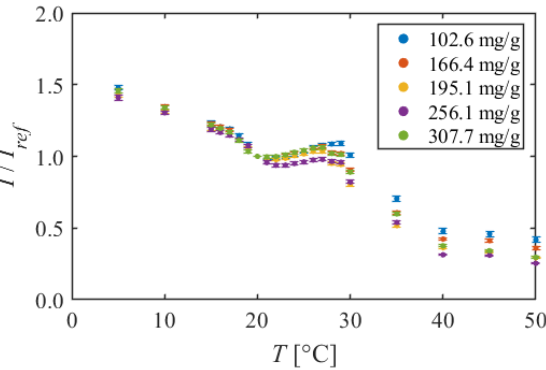
Figure 6. Calibration curves of PMMA + EtOH + Toluene in different dye concentrations. The reference condition is T = 20 ◦ C and P = 100 kPa.